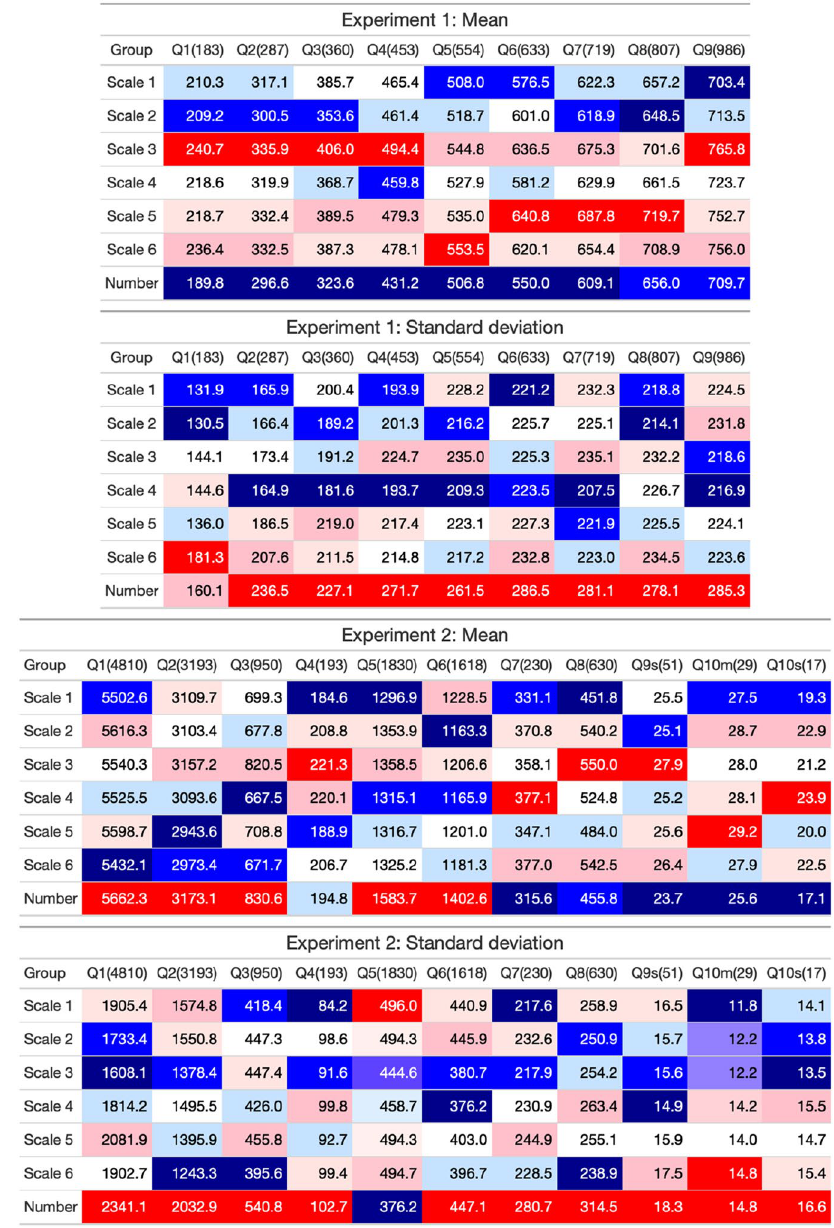
Figure 5. Heatmap of basic statistics (mean and standard deviation) of numerical estimates in Experiments 1 and 2. Each cell is colored based on the order in each question [lowest value (dark blue)-median (white)-highest value (dark red)]. The numbers in the parenthesis next to the question numbers denote the correct